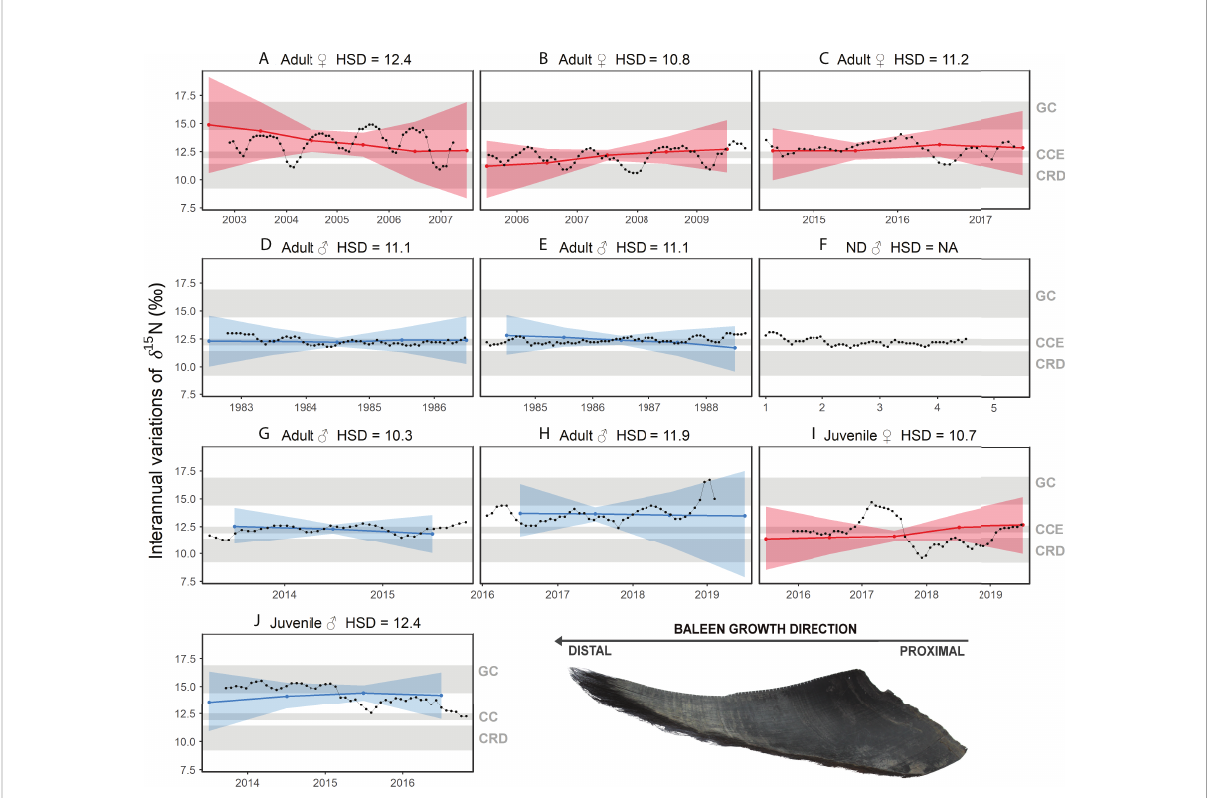
FIGURE 2 Interannual random effects on d 15 N values along nine individual blue whale baleen plates as a function of time. The hyper-standard deviation (HSD) of the random-effect likelihoods is reported for each whale. Colors represent females (red), and males (blue). Colored dots and lines are the medians of the random effects, and colored shaded areas are the 95%-credible intervals. Gray shading represents the expected d 15 N values of baleen of blue whales foraging in the Gulf of California (GC), California Current Ecosystem (CCE), and the Costa Rica Dome (CRD). Figure shows whales (A – J) . HSD could not be estimated for whale (F) given the lack of information on stranding date, so the temporal scale corresponds to the number of years re fl ected in the baleen